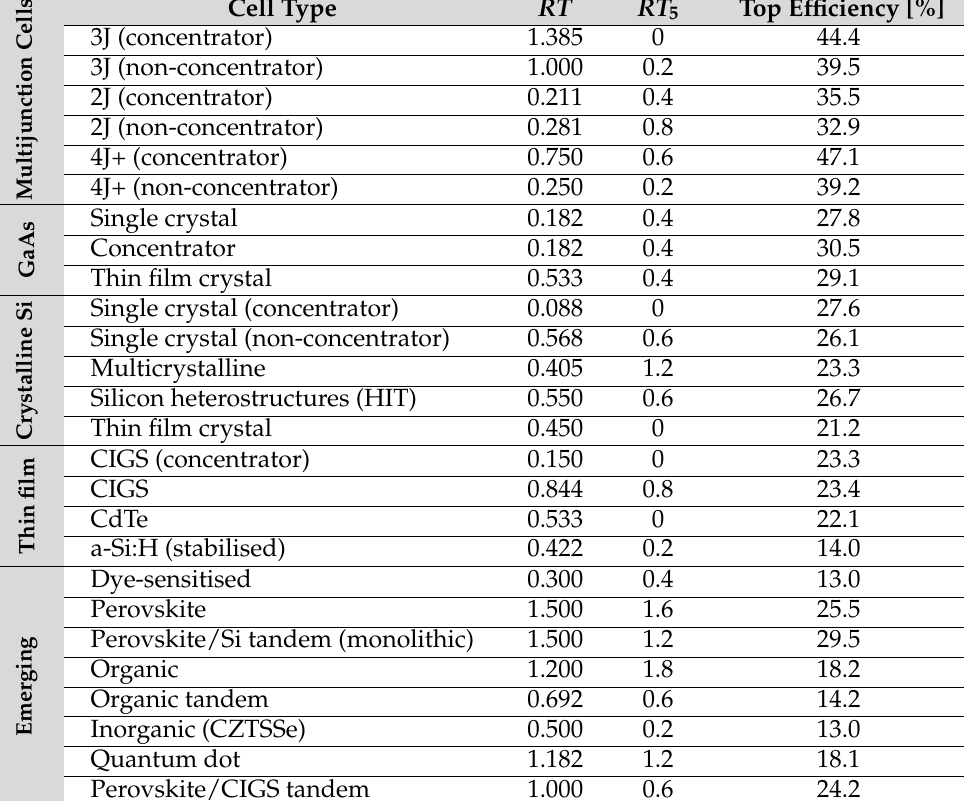
Table 1. Breakthroughs and research tendencies per cell type